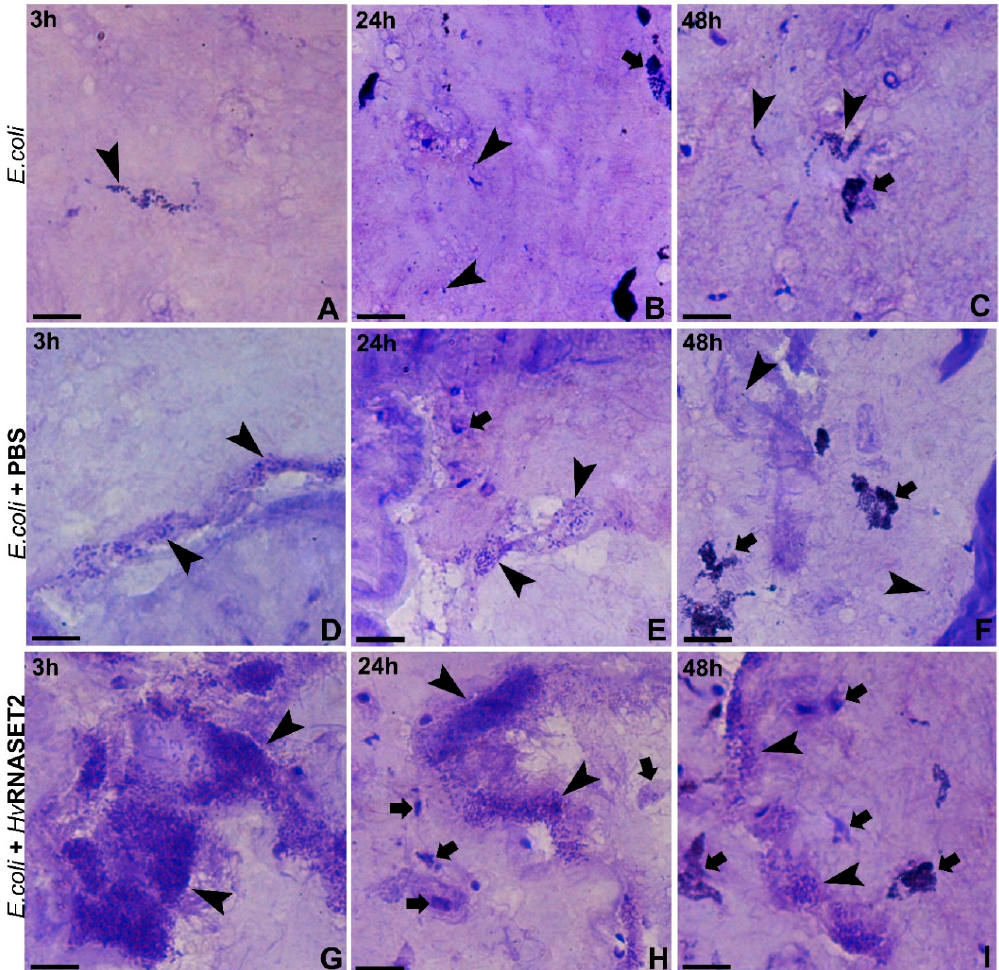
Figure 6. In vivo experiments. ( A – C ) E. coli alone injected in the leech body wall. Tissues were analyzed 3 h after treatment; bacterial cells appeared randomly distributed (arrowheads) and only a few resident cells (arrows) were detectable. ( D – F ) E. coli were pre-incubated with PBS for 3, 24 and 48 h and injected into the leech body wall. Tissues were analyzed after 3 h of treatment, and microorganisms appeared randomly distributed (arrowheads) with few resident cells clearly visible (arrows). ( G – I ) E. coli pre-incubated with r Hv RNASET2 for 3, 24 and 48 h and subsequently injected into the leech body wall. Tissues were analyzed 3 h after treatment, and bacterial cells appeared extremely agglutinated. The microorganism aggregates were evident (arrowheads) for all times, and a larger number of endogenous leech cells were observed surrounding bacterial clusters (arrows). These data confirm the ability of Hv RNASET2 in recruiting immune cells to the challenged area. Scale bars: ( A – I ) 10 µm. In order to confirm the recruitment and the activation of phagocytic macrophages, acid